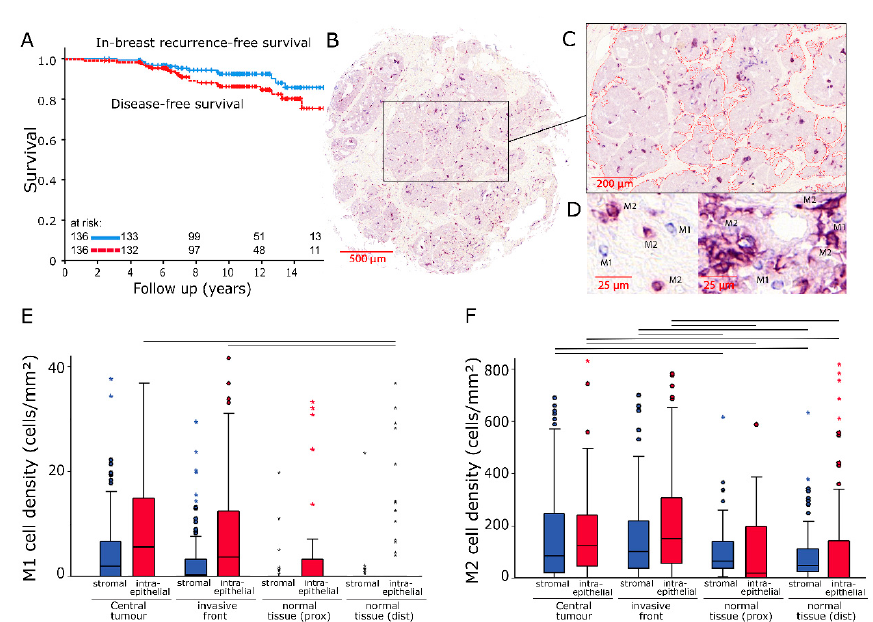
Figure 1. ( A ) In-breast recurrence-free survival and disease-free survival of the studied patient cohort analysed with the Kaplan–Meier method and log-rank test. ( B ) Scanned image of a representative breast cancer tissue microarray core (200 × magnification). ( C ) Epithelial tumour compartment marked with an image analysis software. ( D ) Representative examples of M1 (IHC CD68 + ; blue) and M2 (IHC CD68 +/ CD163 + ; violet) tumour associated macrophages (TAMs). ( E , F ) Stromal and intraepithelial cell density distributions of M1 and M2 TAMs in samples from four di ff erent locations. The central line represents median values while the box is indicative of the interquartile range (IQR). Whiskers represent 1.5 × IQR or minimum / maximum. Outliers are indicated by points (up to 3 × IQR) or asterisks ( > 3 IQR). Black bars signify p < 0.05 in Student’s t